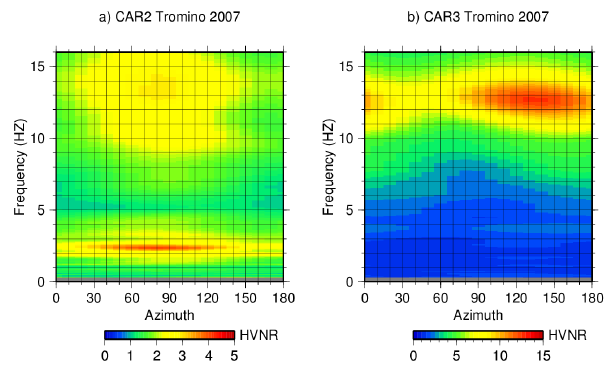
Fig. 3. Azimuthal variation of HVNR values at the sites CAR2 (a) and CAR3 (b) from noise measurements carried out on July 2007 using a tromograph.